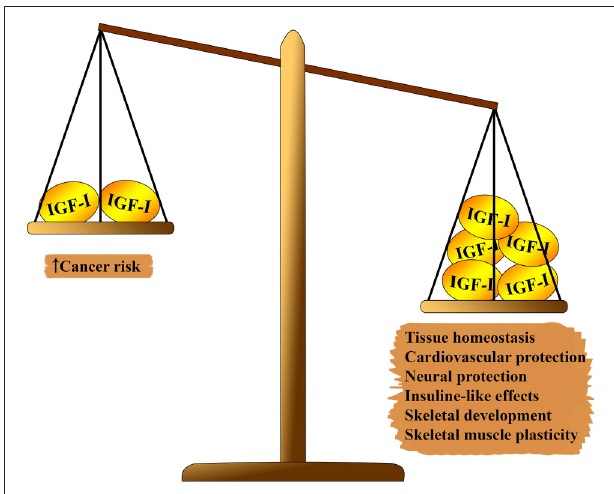
FIGURE 1 | Pleiotropic effects of IGF-1 on health